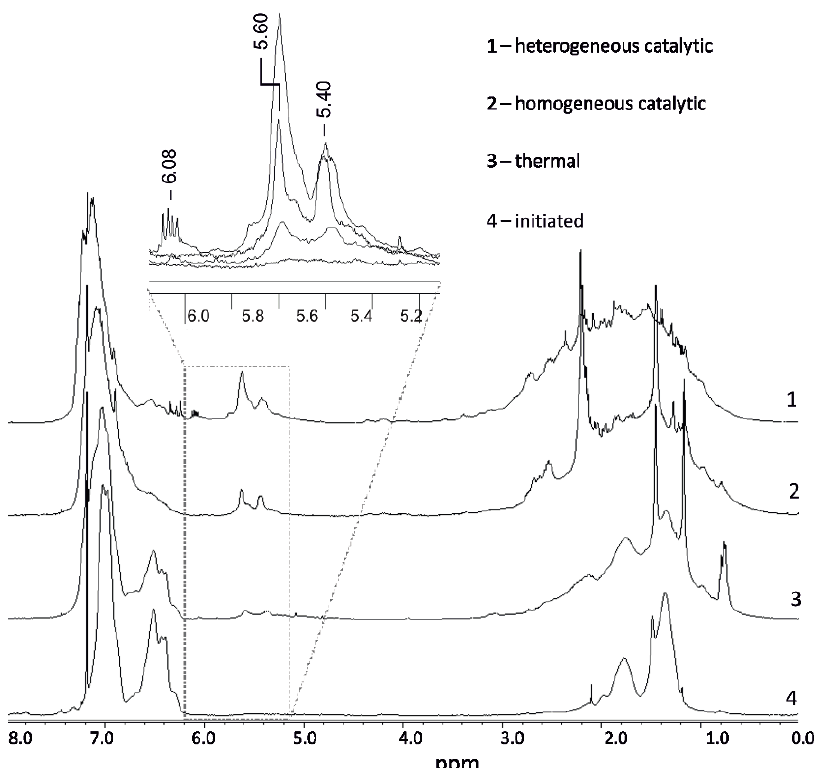
Figure 9. Comparison of 1 H-NMR spectra of the cooligomers synthesized by different cooligomerization methods.